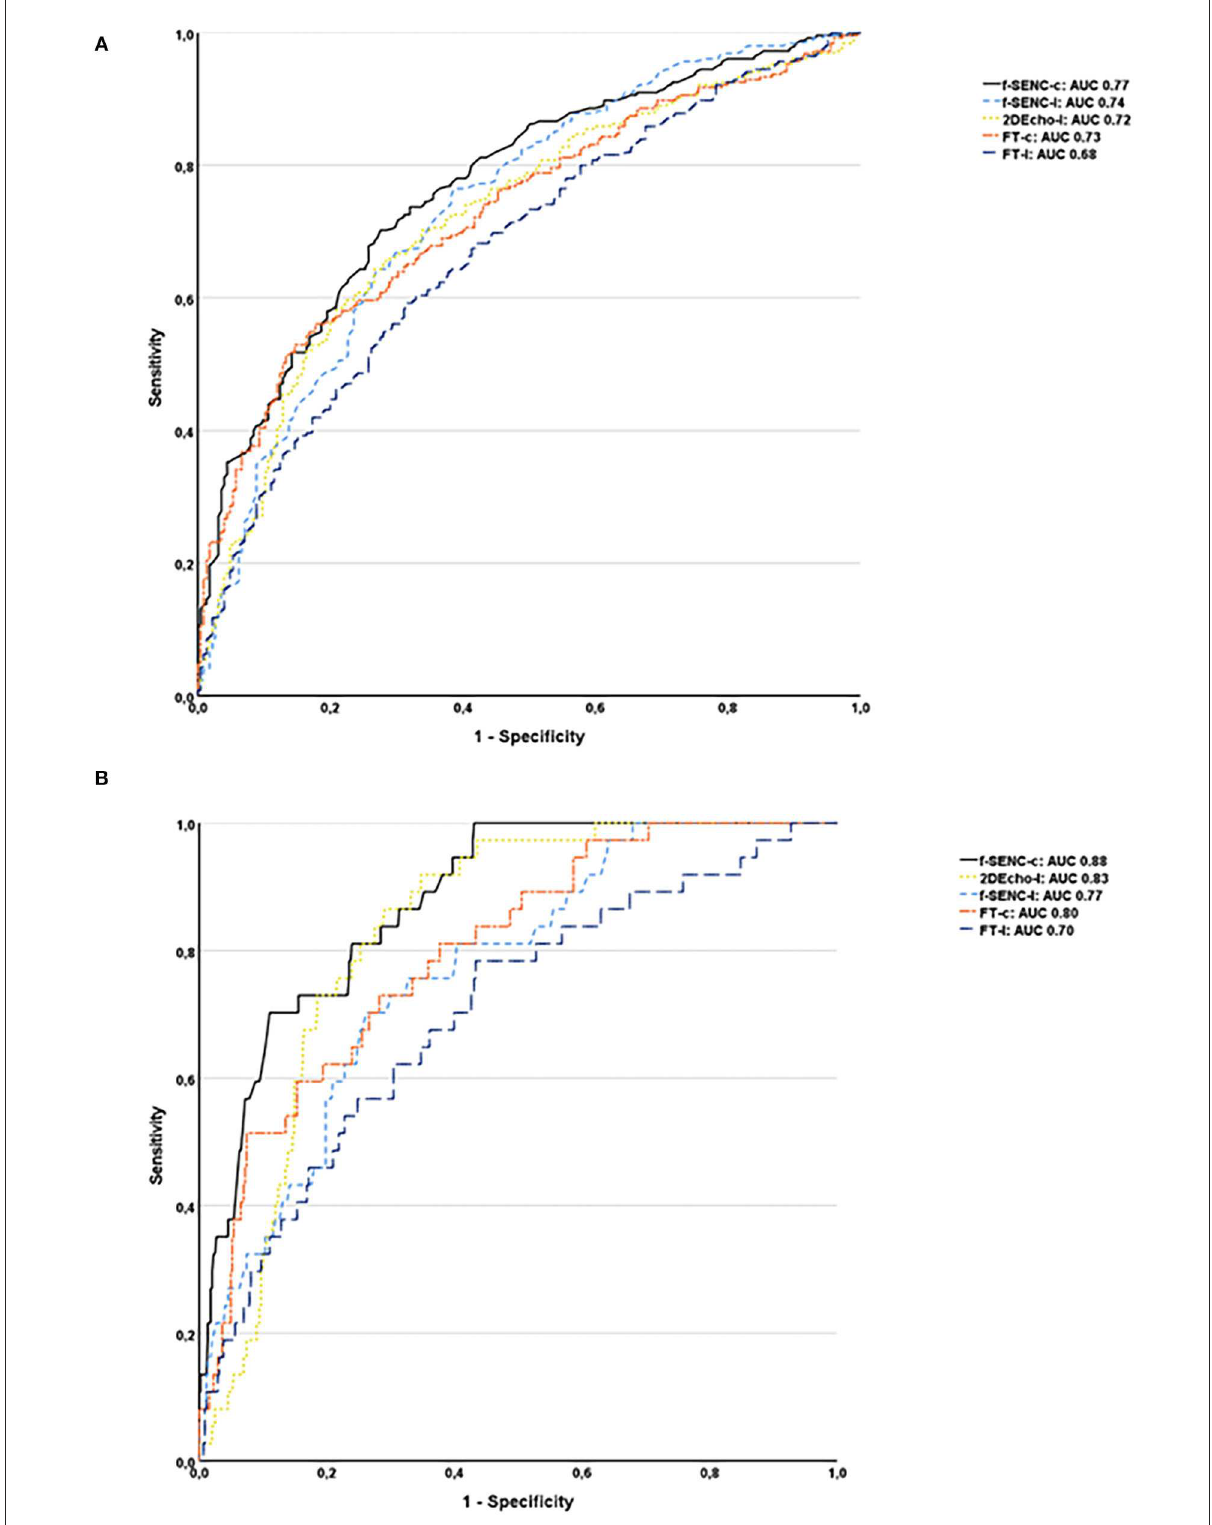
FIGURE8 Receiver operator characteristics analysis of all infarcted segments (A) and segments with the transmurality > 50% for fast-SENC, FT, and 2DEcho are presented with circumferential strain (-c), segmental longitudinal strain (-l), and area under the curve (AUC) (B)